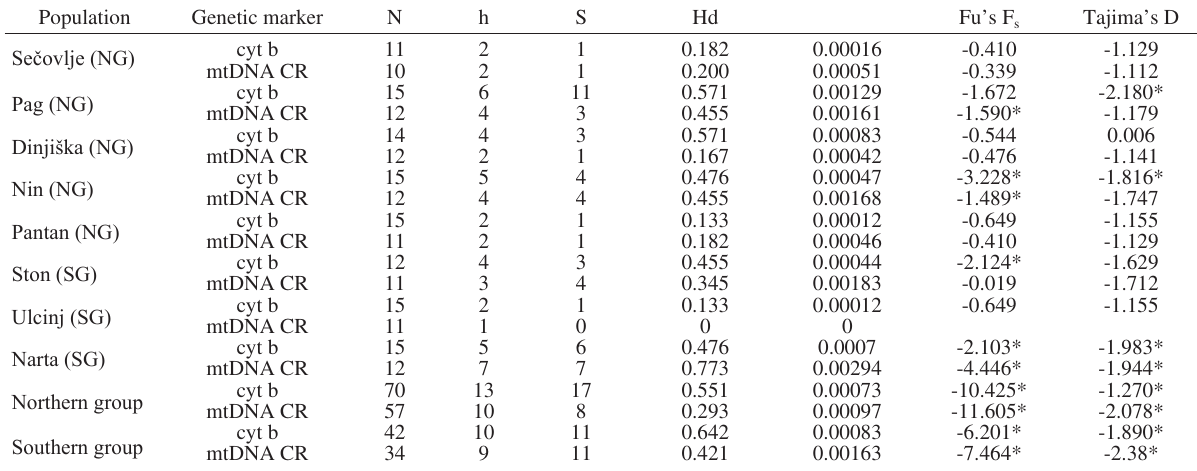
Table 1. – Intrapopulational genetic diversity and tests of selective neutrality for east Adriatic Aphanius populations, based on two molecular markers. N, number of sequences; h, number of haplotypes; S, number of polymorphic sites; Hd, haplotype diversity; Π , nucleotide diversity; and Tajima’s D values; NG and SG explain populations belonging to the Northern and Southern asterisks mark statistically significant Fu’s F S group, respectively.